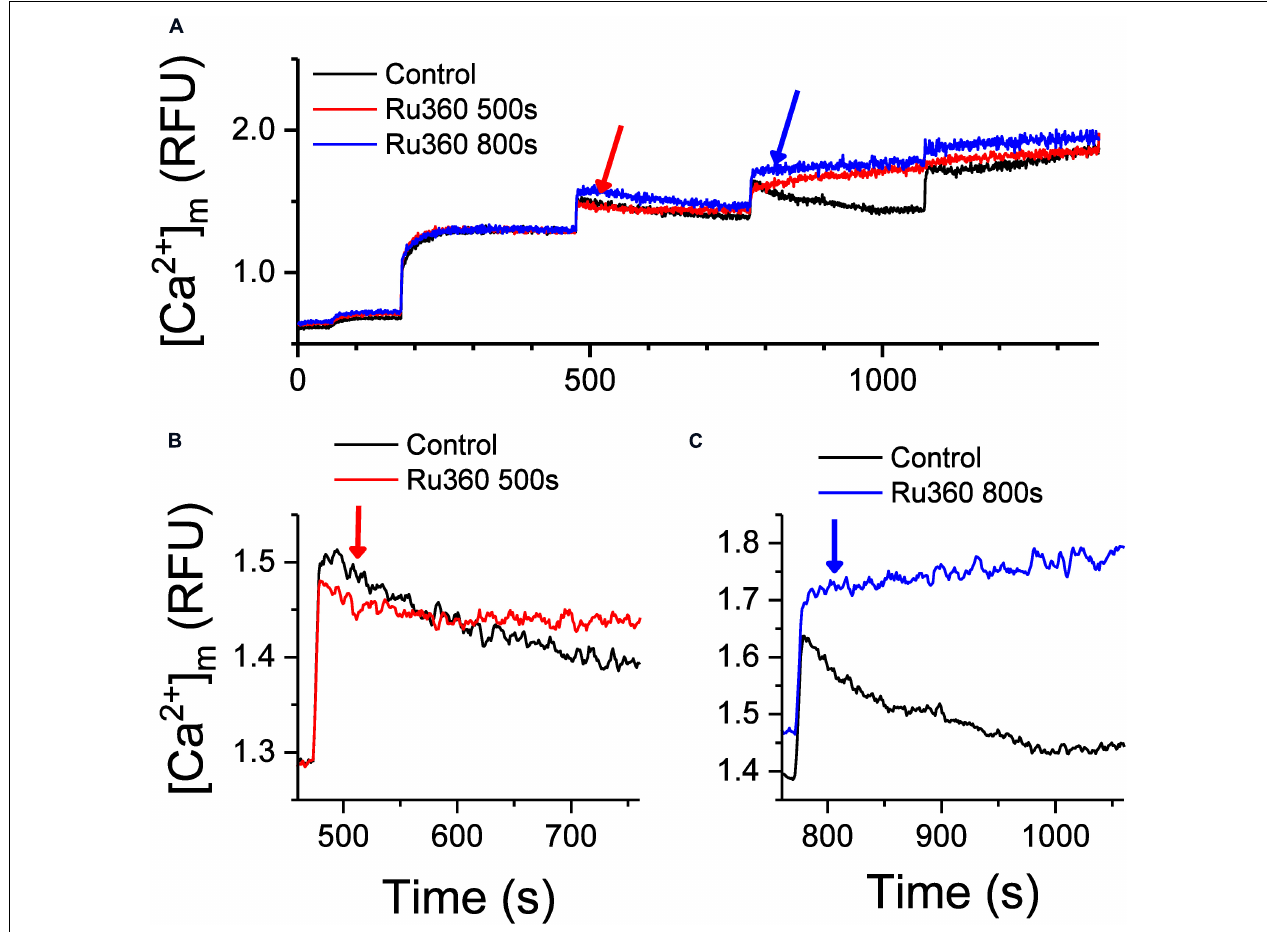
FIGURE 2 | Inhibition of Ca 2 + uptake regulates Ca 2 + buffering and intra-matrix Ca 2 + . (A) Changes in intra-matrix Ca 2 + in mitochondria isolated from rat hearts in response to 20 µ M CaCl 2 boluses in the absence (control, black) or presence of 1 µ M Ru360 applied at 500 s (red) or 800 s (blue). (B,C) are expanded graphs of (A) to highlight the differences in the kinetics of Ca 2 + buffering and steady state mCa 2 + in response to application of